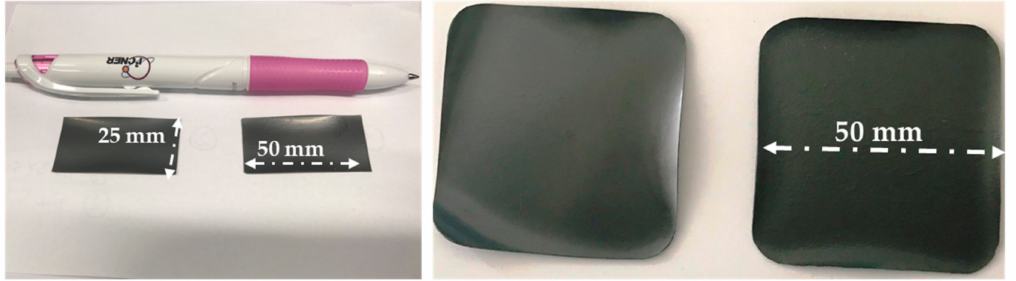
Figure6. Imagesof someofthe initial25 × 50mm 2 and50 × 50mm 2 planarBZCY(54) 8 / 9 2based half-cells, in the end, fired state showing warpage, especially pronounced at the edges.